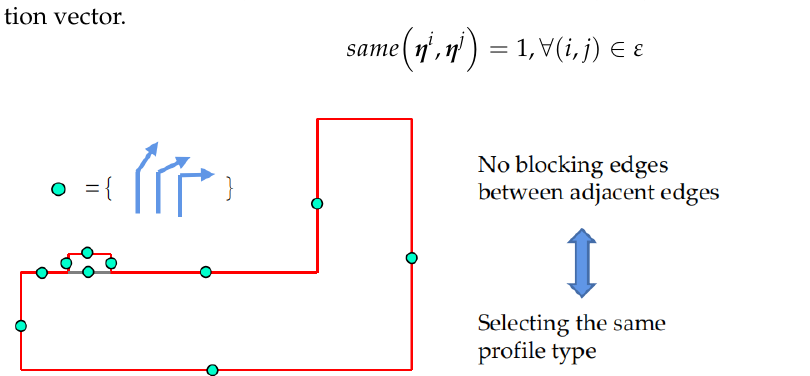
Figure 4. Illustration of the selection of profile types.